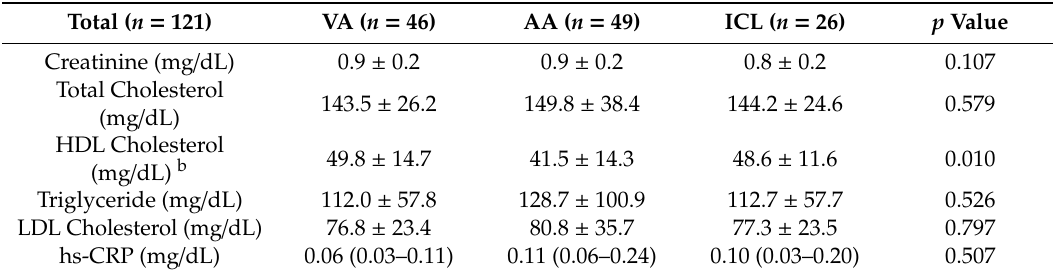
Table 2. Association between cardiovascular risk factors and miR expression.